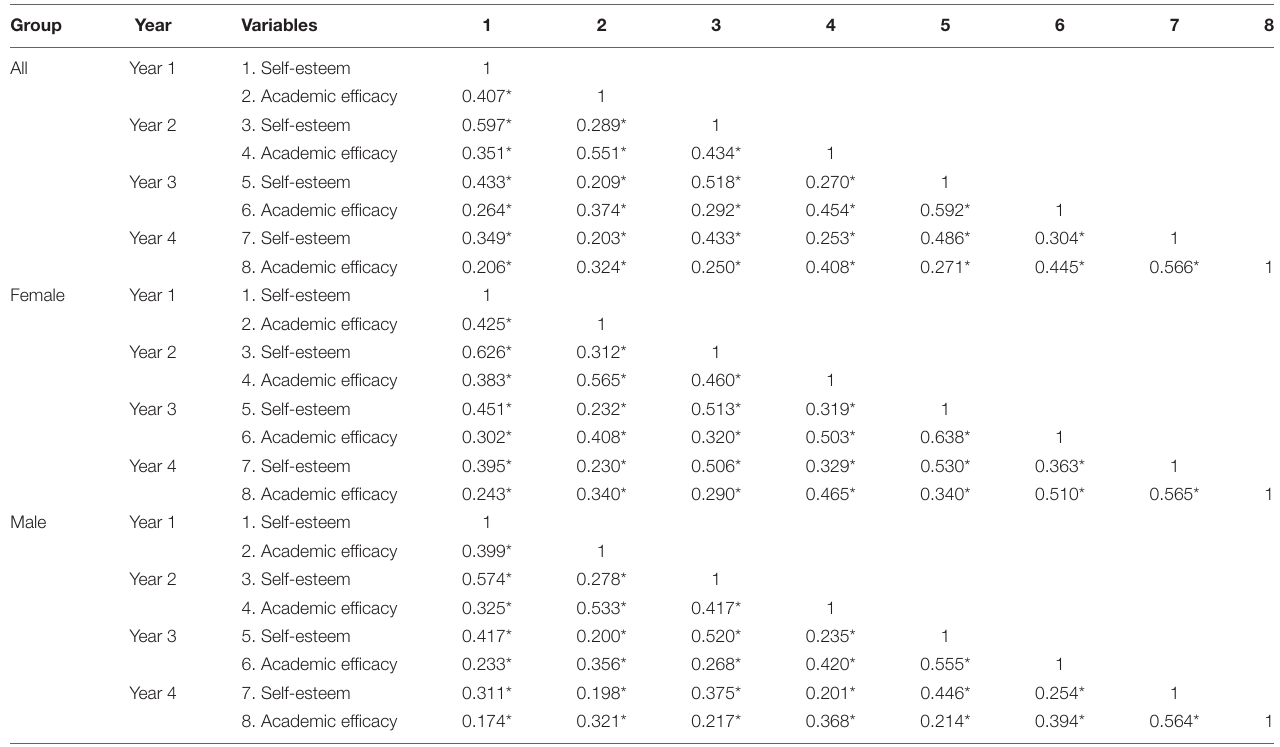
TABLE 1 | Correlation coefficients between self-esteem and academic efficacy.